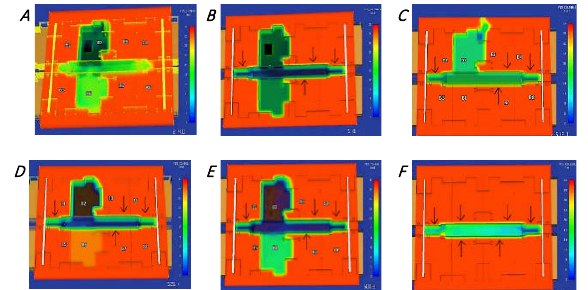
Figure 7. Smoke emission in: (A) main floor of fire (4 th floor) after 214s; (B) 4 th floor after 518s; (C) 12 th floor after 518s; (D) upstairs of 5 th floor after 526s; (E) 6 th floor after 600s; (F) 2 nd floor after 720s.